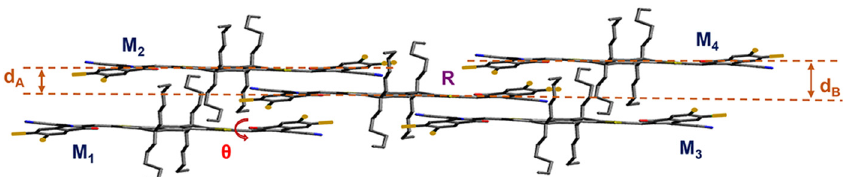
Fig. 7. Representative neighboring system for IDIC-4X, (X=H,F,Cl) with a reference molecule ( R ) and four nearest neighbors (M 1 , M 2 ,M 3 ,M 4 ). Distance de fi nitions for close ( d A ) and distant ( d B ) neighbors along with dihedral angle u between the IDT core and IC end group are also displayed.